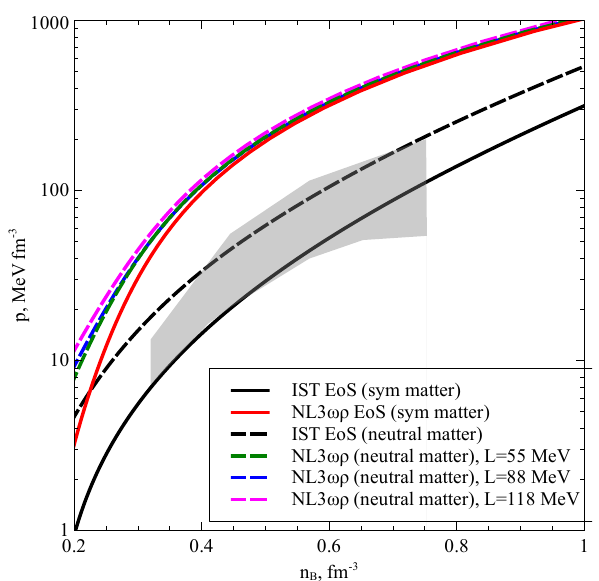
Figure 2. Pressure as a function of baryonic density for symmetric and β -equilibrated nuclear matter for the IST EoS (solid and dashed black curves, correspondingly) and the NL 3 ωρ EoS. The solid red curve corresponds to the NL 3 ωρ EoS for symmetric matters (or NL3, for simplicity). The NL 3 ωρ EoS for the β -equilibrated nuclear matter is shown for L = 55 MeV (dashed green curve), L = 88 MeV (dashed blue curve) and L=118 MeV (dashed magenta curve). The shaded gray area corresponds to the flow constraint for symmetric matter